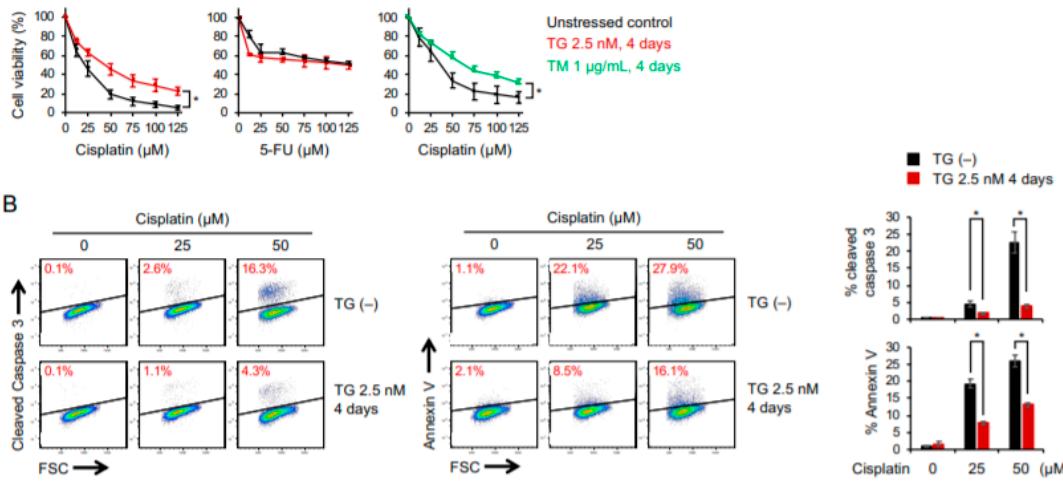
Figure 3 . Adaptation to persistent ER stress enhances chemoresistance to cisplatin. OECM1 cells with or without pretreatment of 2.5 nM of thapsigargin or 1 µg/mL of tunicamycin for 4 days were treated with various dose of cisplatin or fluorouracil (5-FU). ( A ) WST-8 assay of dose-dependent cell viability. ( B ) Representative flow cytometry analysis of cell apoptosis by cleaved Caspase 3 or Annexin-V staining. Data from three independent experiments are shown as the mean ± SEM. Statistical significance was determined by one-way ANOVA and Student’s t -test. *, p < 0.05.